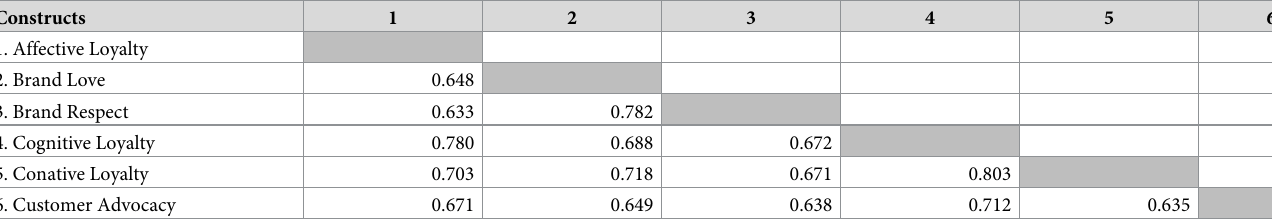
The hypotheses test results presented in Table 4 show a positive direct effect of perceived lovemarks on brand loyalty ( β = 0.521, t = 10.932, p < 0.01) thus lending support to H1. The results show that customer advocacy ( β = 0.358, t = 6.249, p < 0.01) had positive direct effects on brand loyalty that we hypothesised (H2) in this study. Also, H3 came out statistically